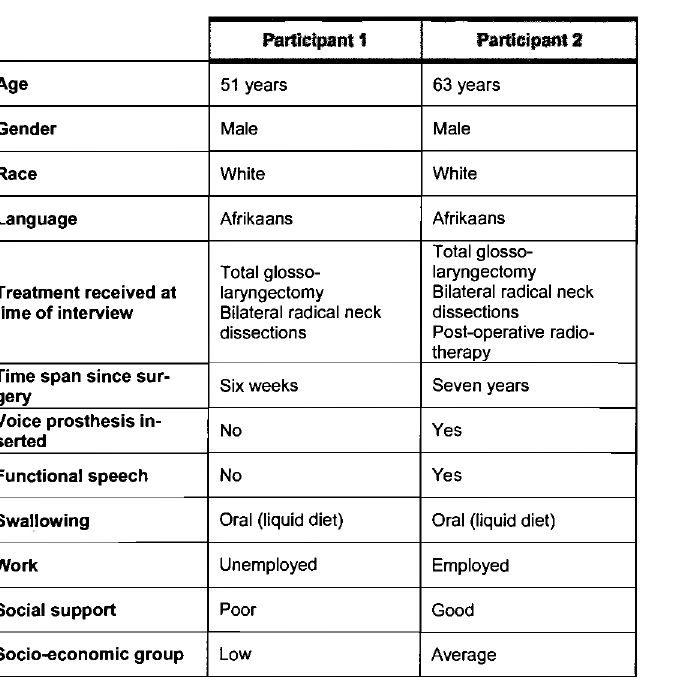
Table 1: Description of the two